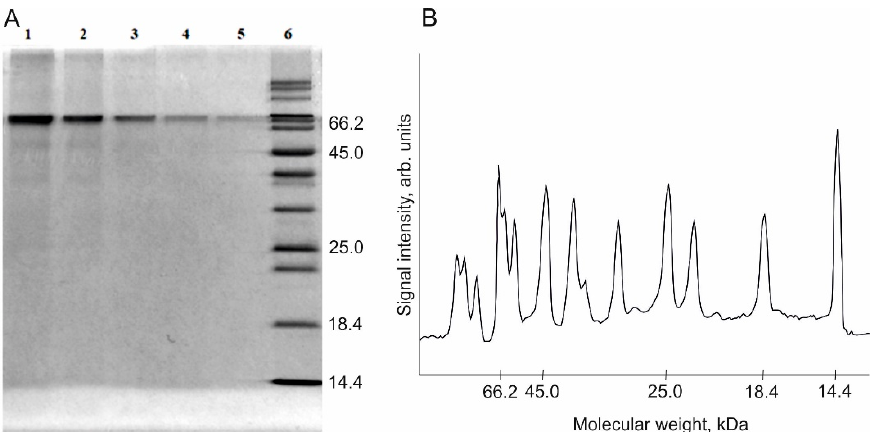
Figure 3. ( A ) An example of the electropherogram of calibration BSA solutions with concentrations 0.2, 0.1, 0.05, 0.025, and 0.0125 mg/mL, respectively (lanes 1–5) and the reference sample with known molecular weights (lane 6). Volume of the applied sample = 10 µL. ( B ) A densitogram of the reference sample.